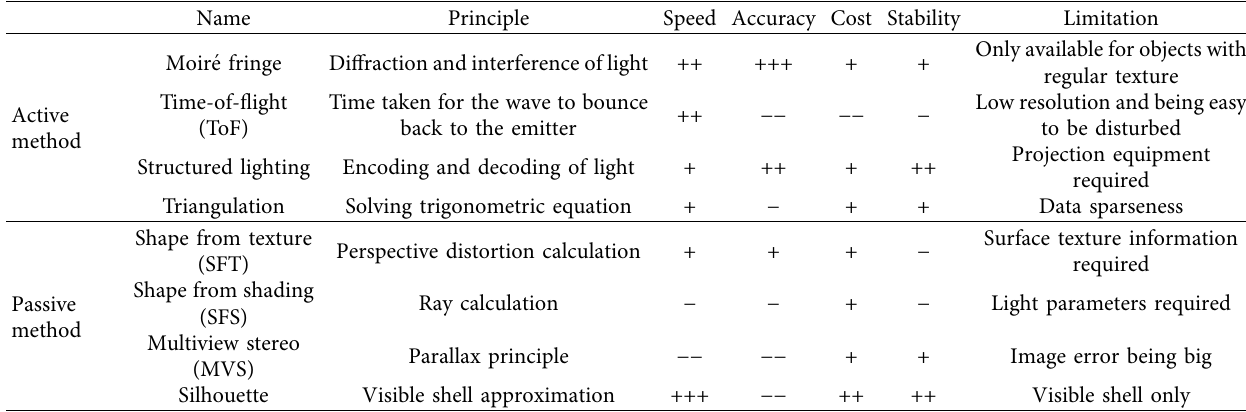
Table 1: Measuring and modeling methods.